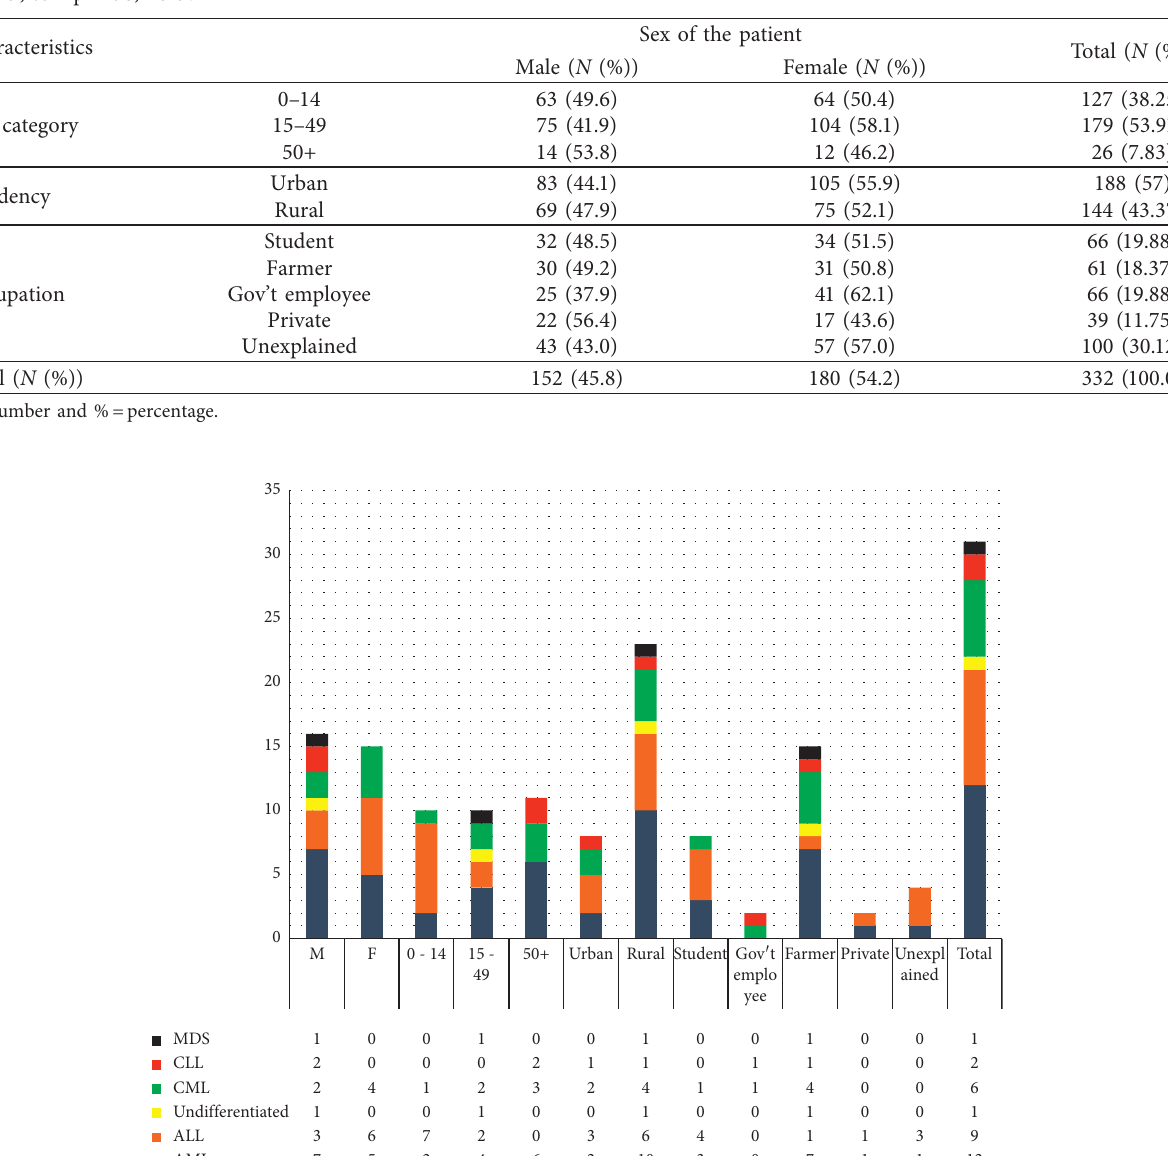
Table 1: Sociodemographic characteristics of patients who have abnormal hematological parameters in Jimma Medical Center from January 1, 2019, to April 30,